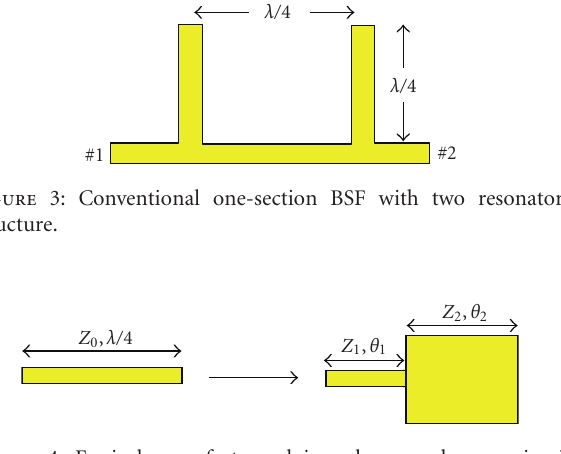
Figure 4: Equivalence of stepped impedance and open circuit quarter-wave sections.